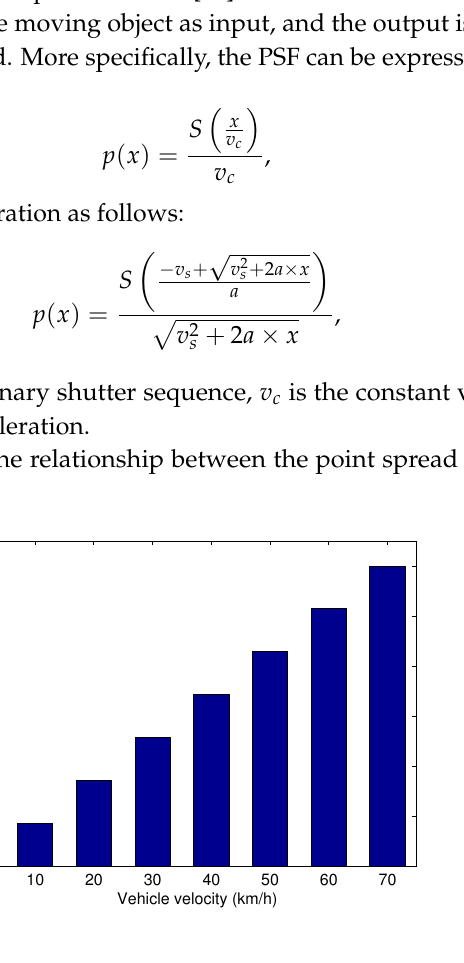
Figure 8. Point spread function over the vehicle